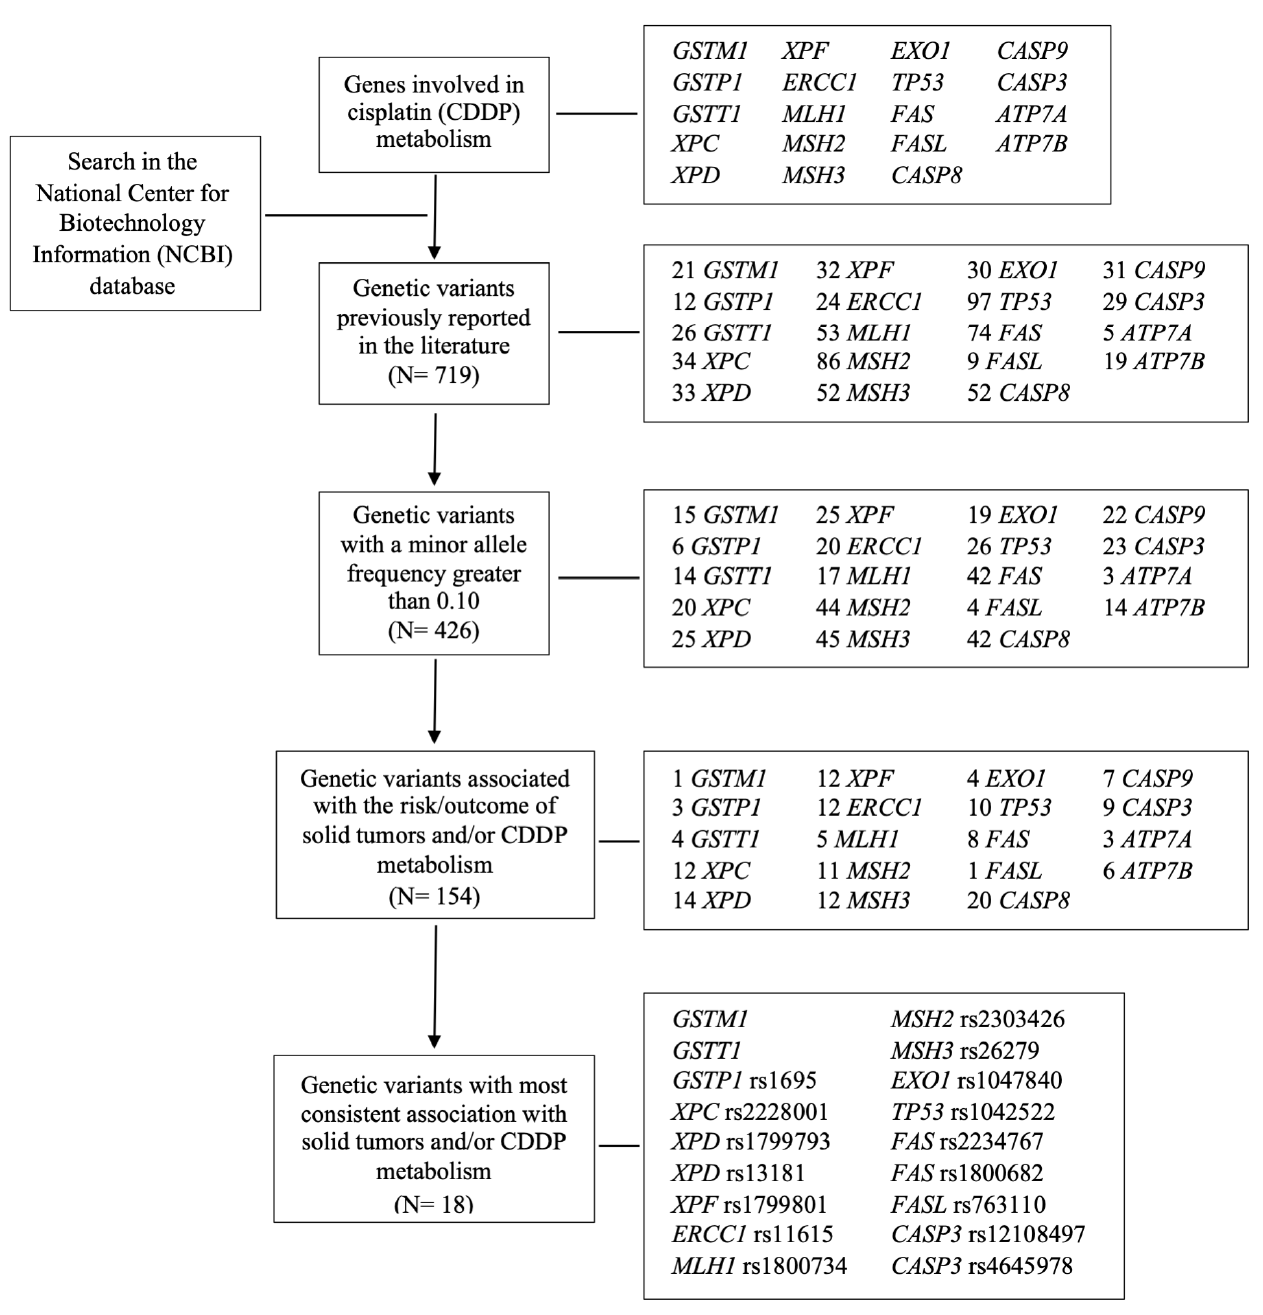
Figure A1. Flowchart illustrating the process used to select the genetic variants included in the study. Initially, the National Center for Biotechnology Information database was searched to identify variations in genes associated with the metabolism of cisplatin (CDDP). A total of 719 genetic variations were identified. Next, 426 genetic variations were selected based on a minor allele frequency greater than 0.10. Subsequently, 154 genetic variations previously associated with the risk or outcome of solid tumors and/or the metabolism of CDDP were selected, and 18 of them with most consistent association were included in the study.